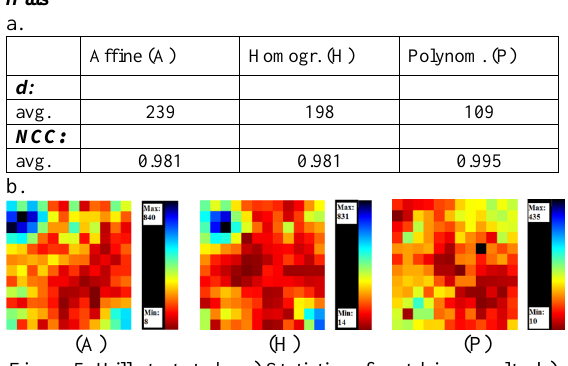
Figure 5: Hills test study. a) Statistics of matching results; b) Colour Map of the distances d for each shape model Crater a.